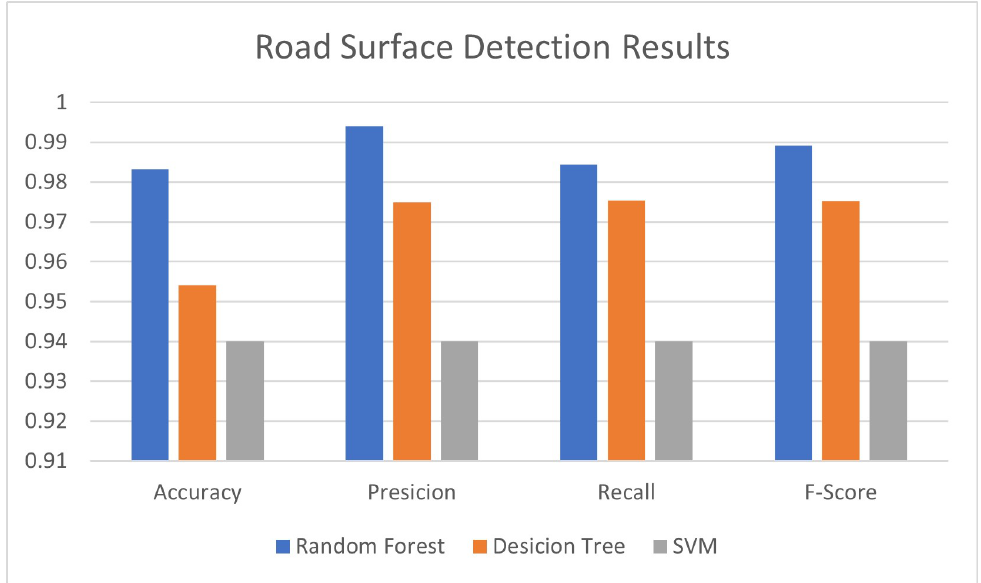
Figure 3. Accuracy, precision, recall and F-score for road surface conditions